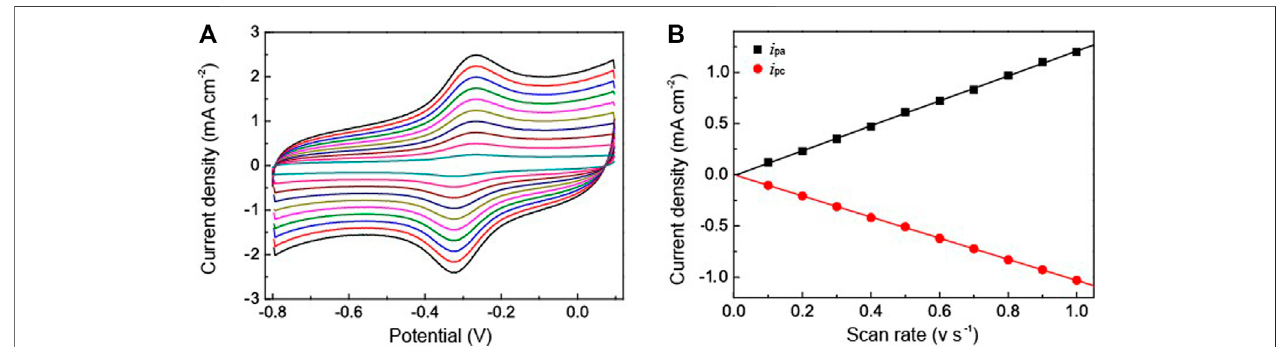
FIGURE5|(A) CV curves ofHRP/Au NPs-PDA-PAA-grapheneat various scanrate ranged from 0.1 — 1V/s inPBS(pH 7.4) (B) istheplotofcathodic/anodic peak current vs. scan rate.